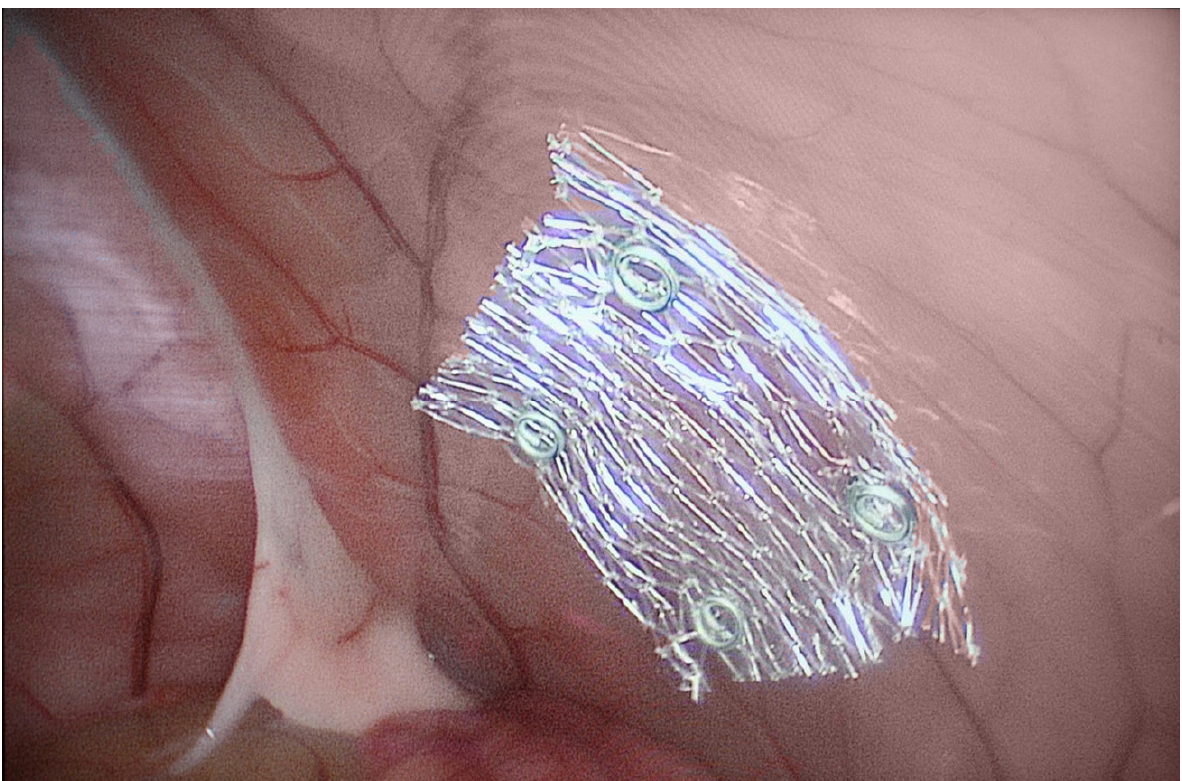
Figure 2. Intraperitoneal placement of ultra-fine PET mesh fixated by surgical tacks.